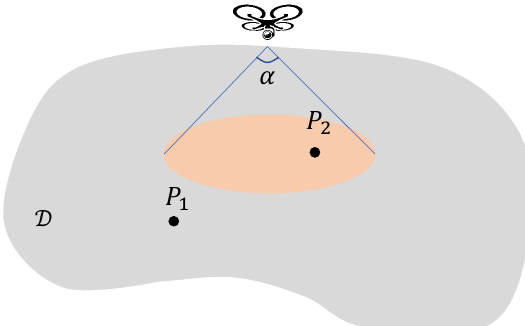
Figure 1. The visibility cone. Point P 2 can be seen by the drone while point P 1